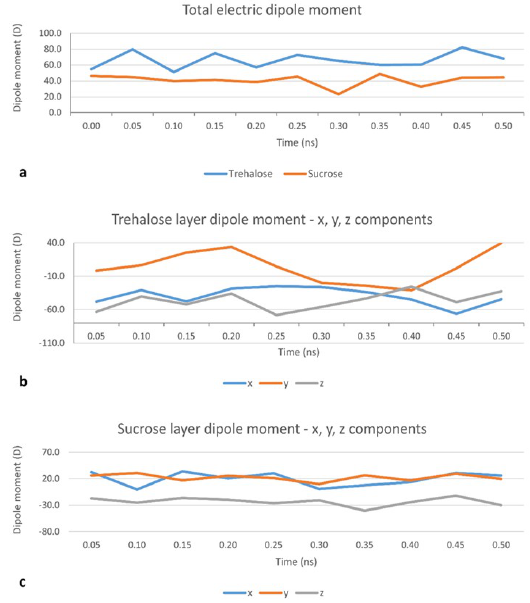
Figure 2. Evolution of total dipole moment of the whole sugar layer during the Molecular Dynamics (MD) set, showing consistently higher values for the trehalose layer ( a ): Evolution of the x, y and z components of the dipole moment ( µ x, µ y and µ z, respectively) for the trehalose layer ( b ) and the sucrose layer ( c ), showing a higher absolute value and higher weight with respect to the x and y components, of µ z for trehalose than for sucrose; z is the direction of the bilayer’s normal, and xy is the plane of the bilayer’s surface.